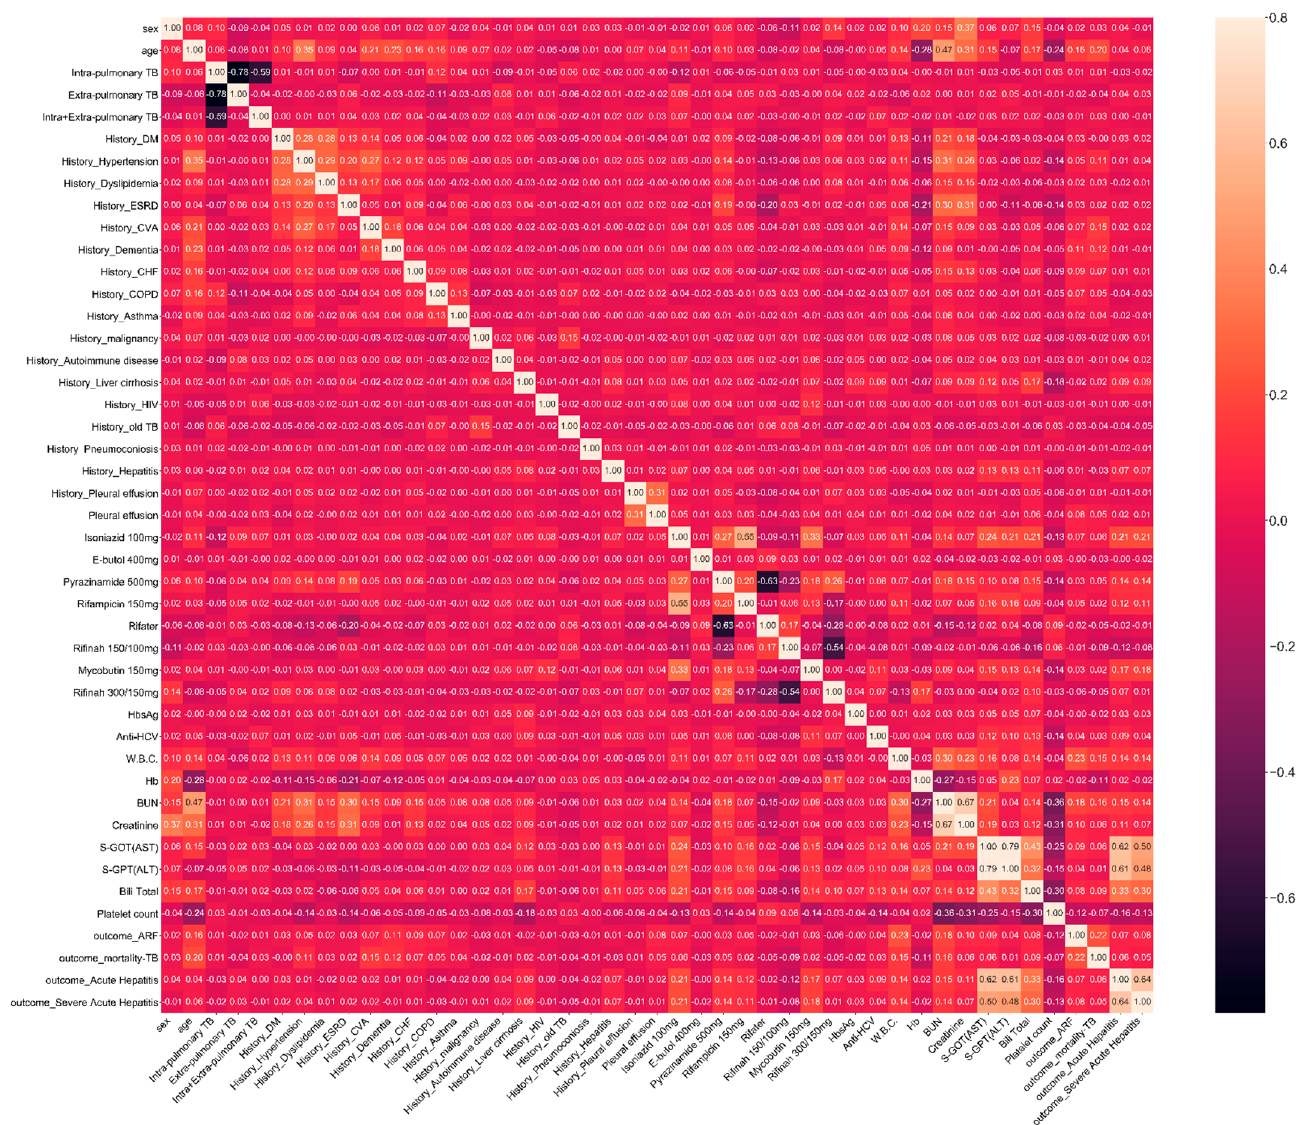
Figure 2. Spearman correlation.